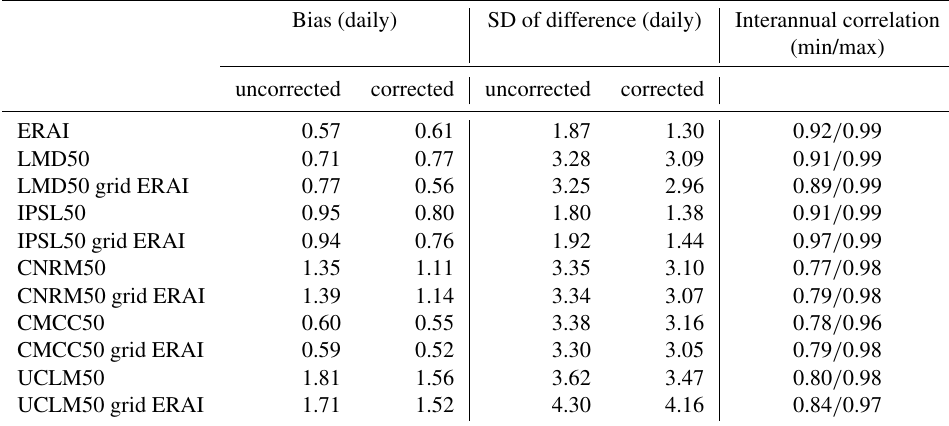
Table 3. Mean bias and standard deviation (SD) in kilograms per meter (kgm − 2 ) of the differences in IWV between models and GPS observations using daily time resolution, and using the data obtained with the correction due to altitude difference or without it. Computation has been done using models on their native grid, or bilinearly remapped on the ERA-Interim grid. The rightmost column indicates the minimum and maximum values of the correlation of the interannual variability of monthly GPS anomalies and model anomalies (one correlation computed by month). Bias (daily) SD of difference (daily) Interannual correlation (min/max) uncorrected corrected